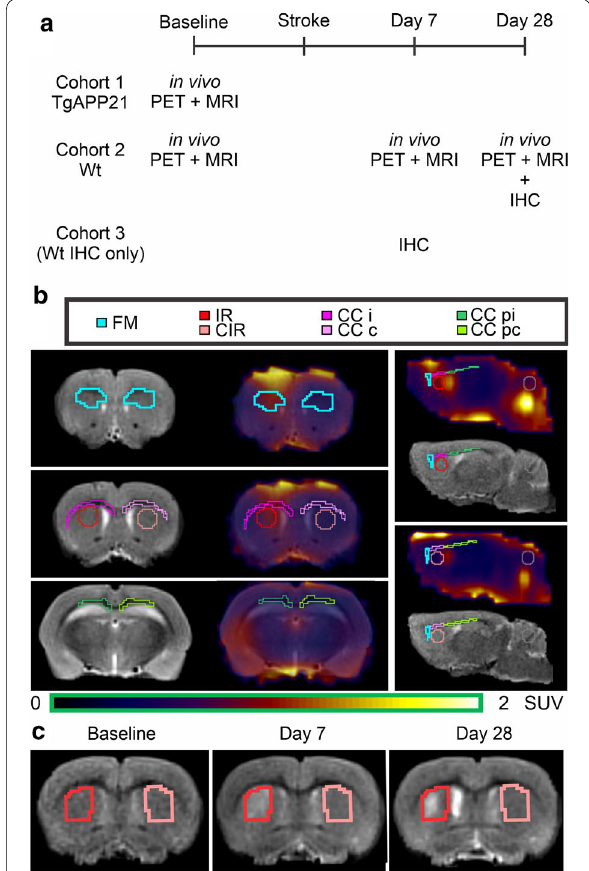
Fig. 1 Analytical methods. a Experimental timeline. b Representative ROIs delineated on T 2 w MRI and applied to fused [ 18 F]FEPPA PET in a control rat at day 7. c Infarct at baseline and post‑stroke day 7 and 28 on T 2 w MRI. c, contralateral; CC, corpus callosum; CIR, contralateral to the infarct region, FM: Forceps Minor; i, ipsilateral; IR, infarct region p,